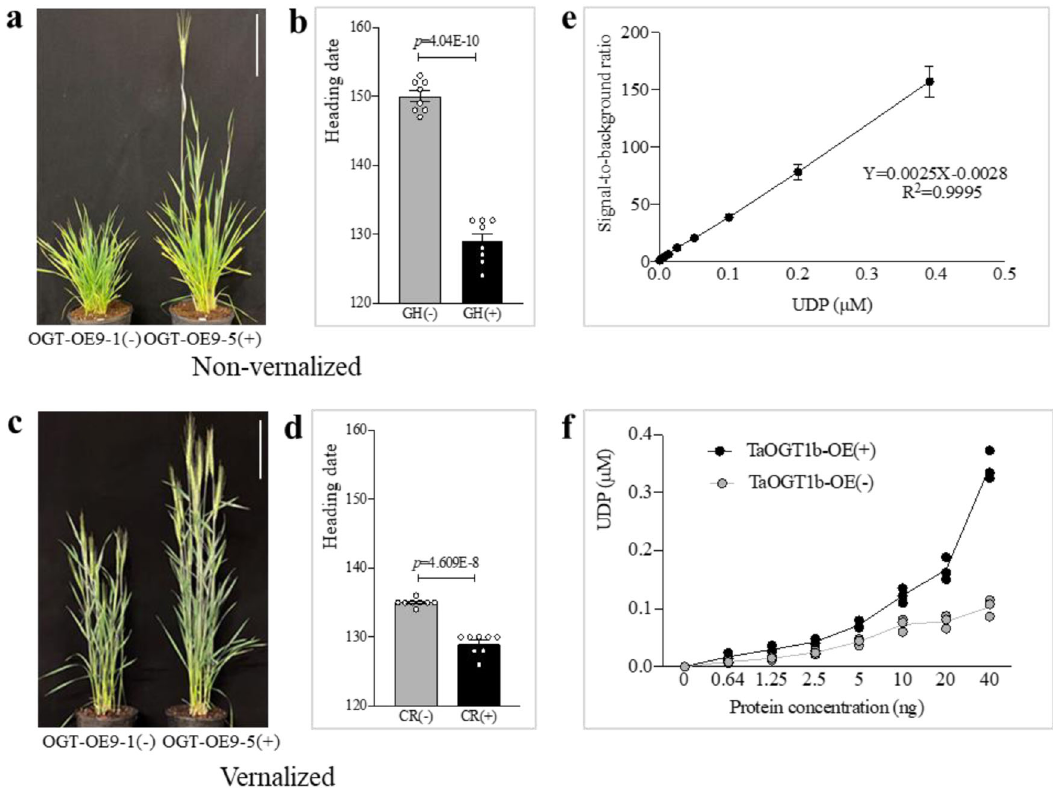
Fig. 4 Constitutive overexpression of TaOGT1b and its enzyme activity. a TaOGT1b from Billings was overexpressed in Duster. A transgenic (right) and a non-transgenic plant (left) grown in the greenhouse without vernalization are shown. b Comparison of the mean heading date for transgenic and non- transgenic plants in the two T 1 populations without vernalization. c A transgenic (right) and a non-transgenic plant (left) grown in the greenhouse with vernalization. a , c Scale bar = 15 cm. d Comparison of the mean heading date for transgenic and non-transgenic plants in the two T 1 populations with vernalization. b , d Statistical comparison of the mean heading date was performed using a two-tailed unpaired Student ’ s t test to determine the signi fi cance level between transgenic and non-transgenic plants ( n = 8). The error bars indicate standard error. e A UDP standard curve for the amount of UDP ( x -axis) and the signal-to-background ratio ( y -axis) based on the luminescence reading in the samples ( n = 3). f Comparison of TaOGT1b enzyme activity in the total protein extract from the leaves of TaOGT1b-OE9 transgenic and non-transgenic plants. The x and y axes represent the amounts of protein (ng) and UDP (calculated from the UDP standard curve) in the samples ( n = 3), respectively. Source data underlying ( b , d – f ) are provided as a Source Data fi